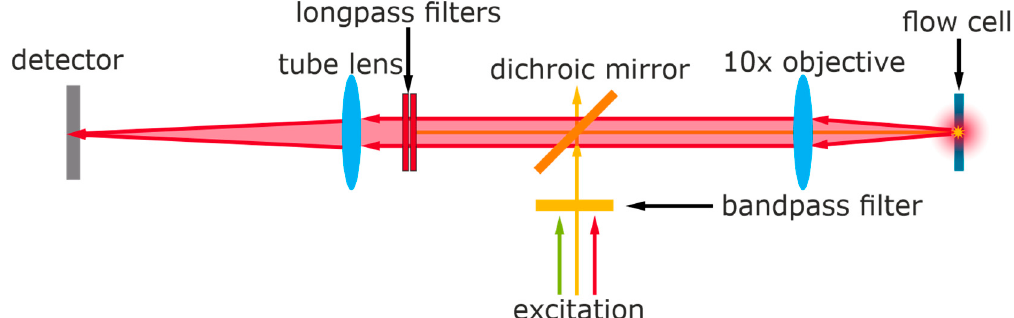
Figure 2. The light path of the detector setup with semiconductor laser excitation (yellow) and fluorescence (red) which is recorded as a signal by the Peltier-cooled CMOS detector.